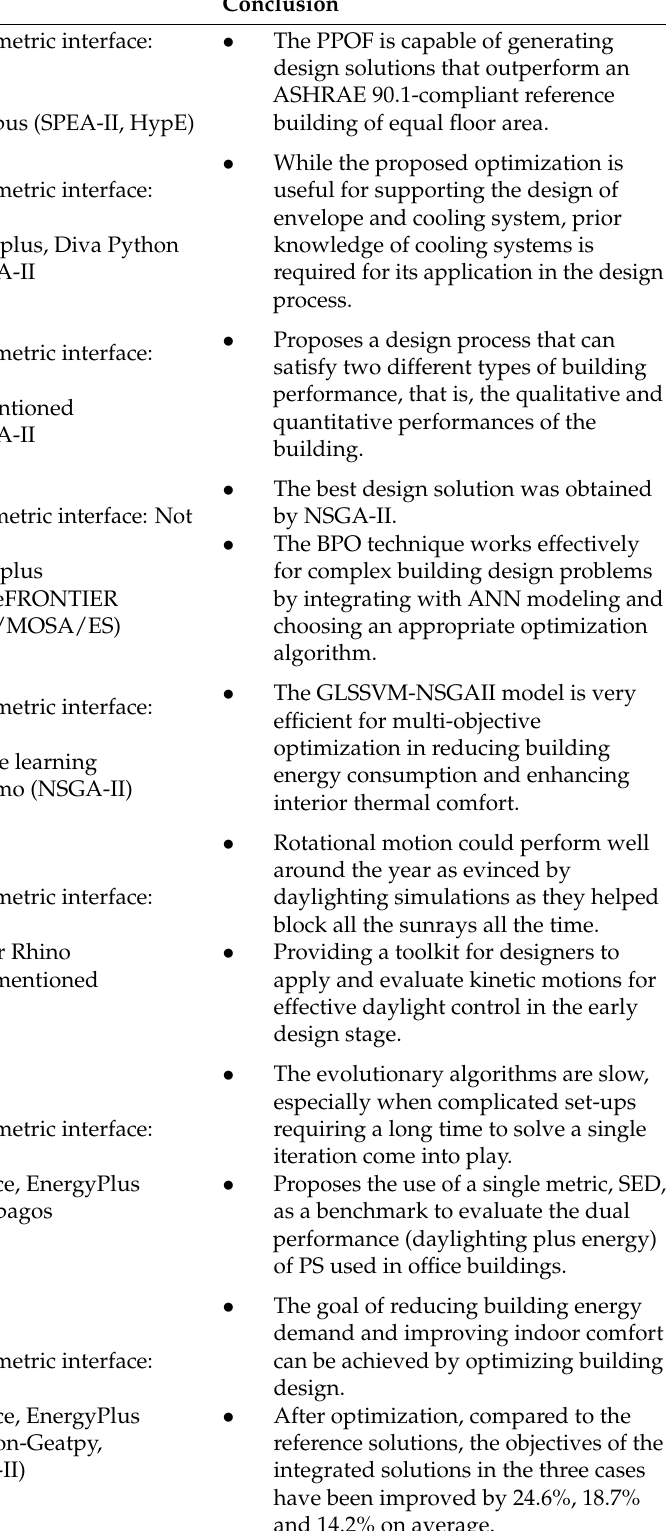
Table 2. Research on the combination of parametric design and